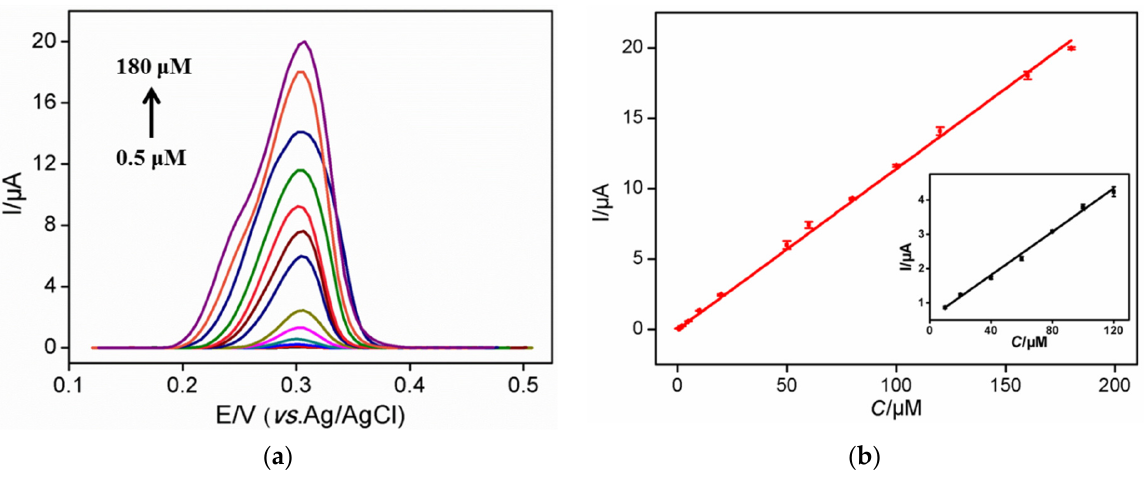
Figure 4. ( a ) Differential pulse voltametric curves of NH 2 -VMSF/ErGO/SPCE to various concentrations of UA (from bottom to up: 0.5; 1; 2; 5; 10; 20; 50; 60; 80; 100; 120; 160; 180 μ M) in 0.1 M HAc-NaAc (pH 5). ( b ) The corresponding calibration curves for the detection of UA using NH 2 -VMSF/ErGO/SPCE. Inset is the corresponding calibration curve for the detection of UA using ErGO/SPCE.